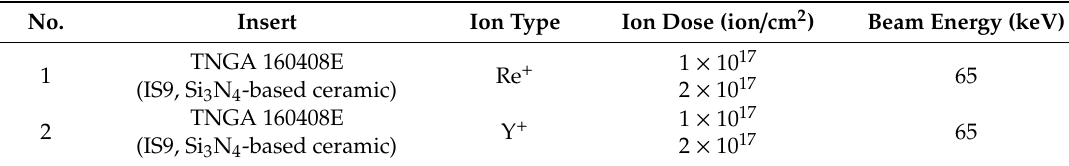
Table 1. Ion implantation